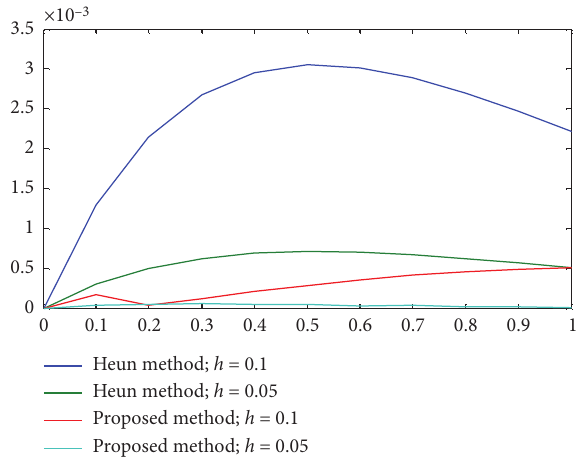
Figure 4: Numerical solutions and exact solution for Example 3.